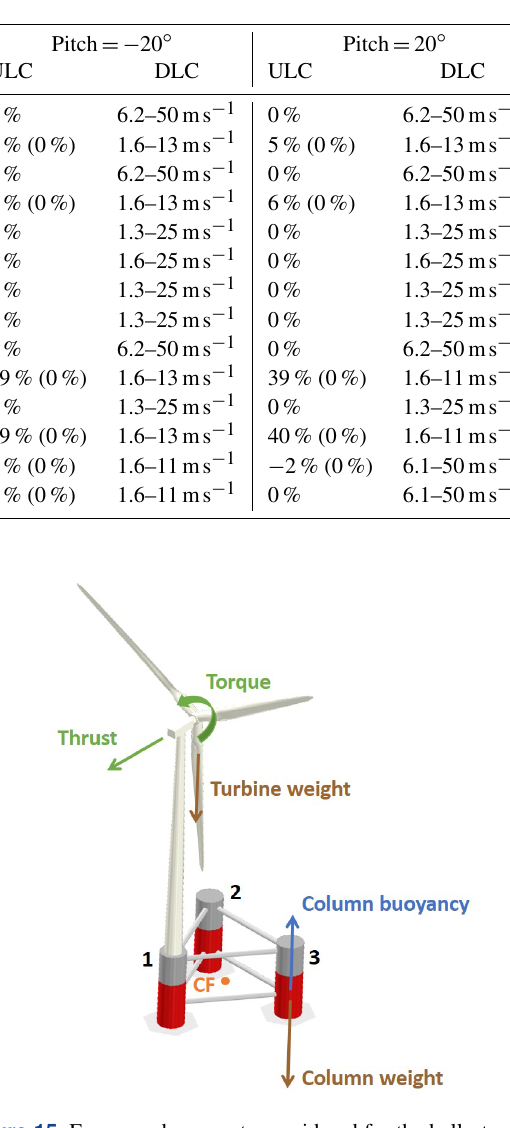
Table 6. Comparison of ultimate loads for platform pitch angle 0 ◦ , 20 ◦ (wake-up), and − 20 ◦ (wake-down).